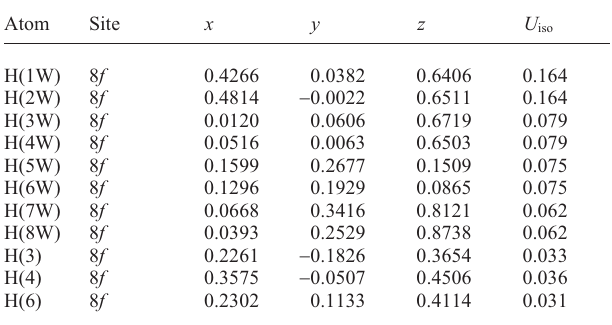
Table 2. Atomic coordinates and displacement parameters (in Å 2 ) .